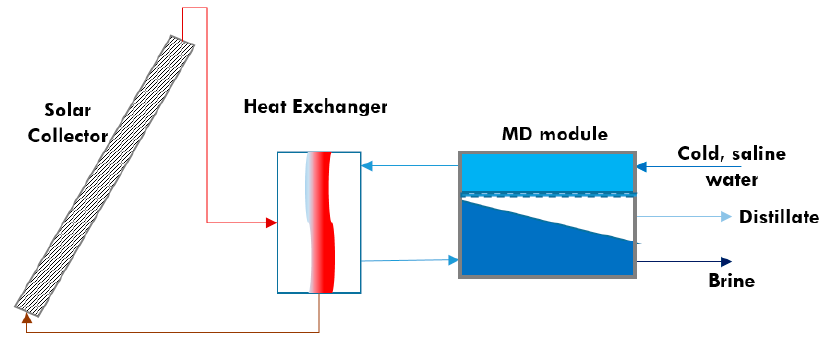
Figure 14. Flow schematic of an MD unit powered by solar collectors with a heat exchanger. ChemEngineering 2018 , 2 , x FOR PEER REVIEW